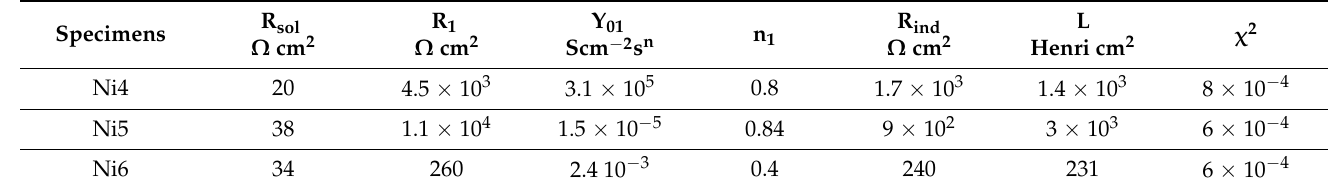
Figure 9. EC used to generate the simulated data for specimens Ni4, Ni5, and Ni6. Table 4. Main parameters of the EC used for specimens Ni4, Ni5, and